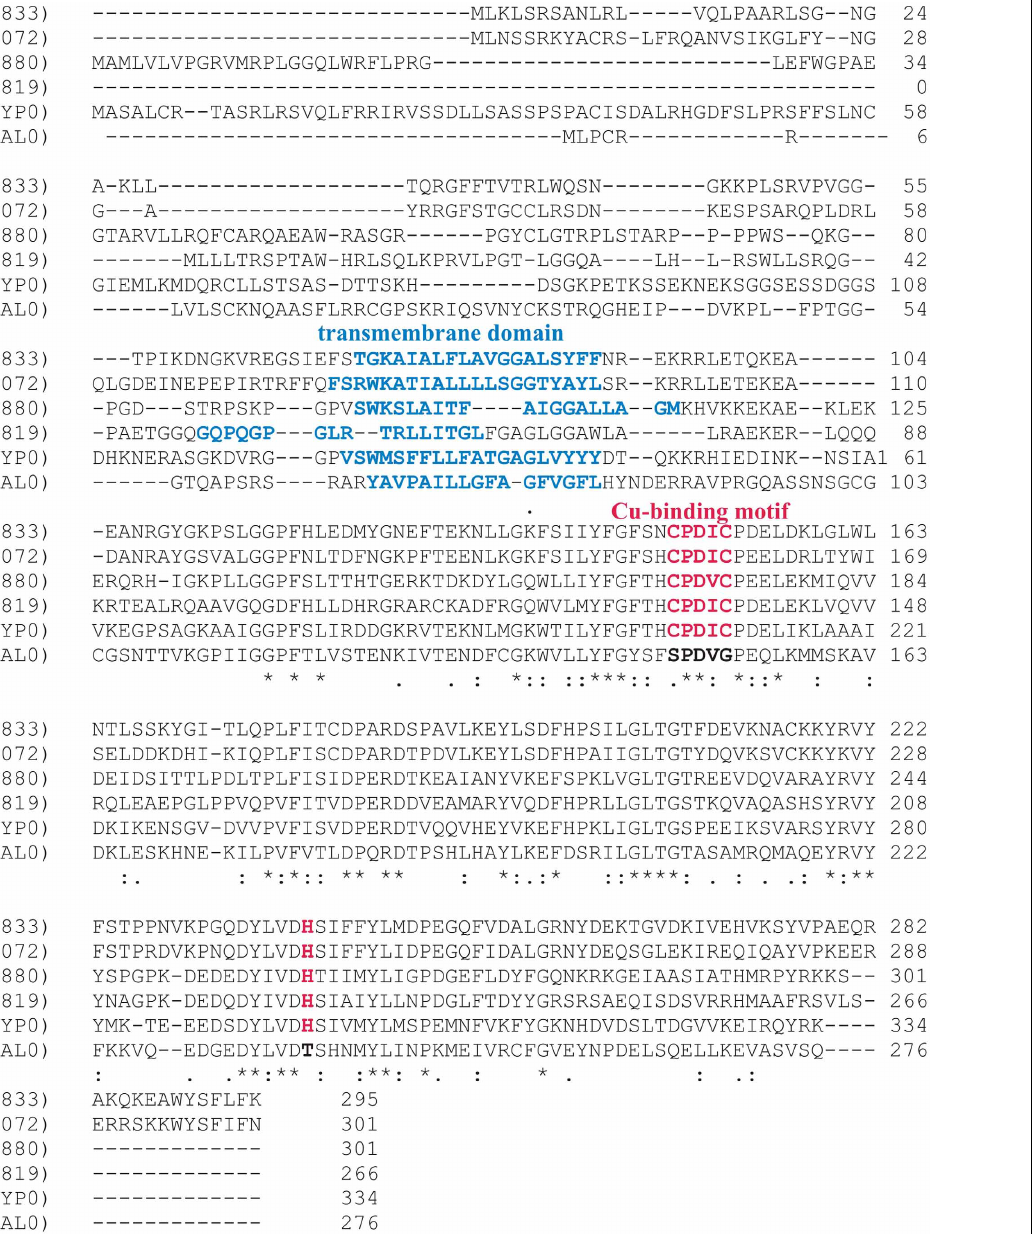
conserved in all sequences, “.” conserved in some sequences, “:” homologous in all sequences). The predicted transmembrane segments (TMPred; Hofmann and Stoffel, 1993) are shown in blue. The amino acids involved in Cu-binding which includes the CxxxC motif as well as one histidine residue (Rentzsch et al., 1999; Nittis et al., 2001) are marked in red, if present.